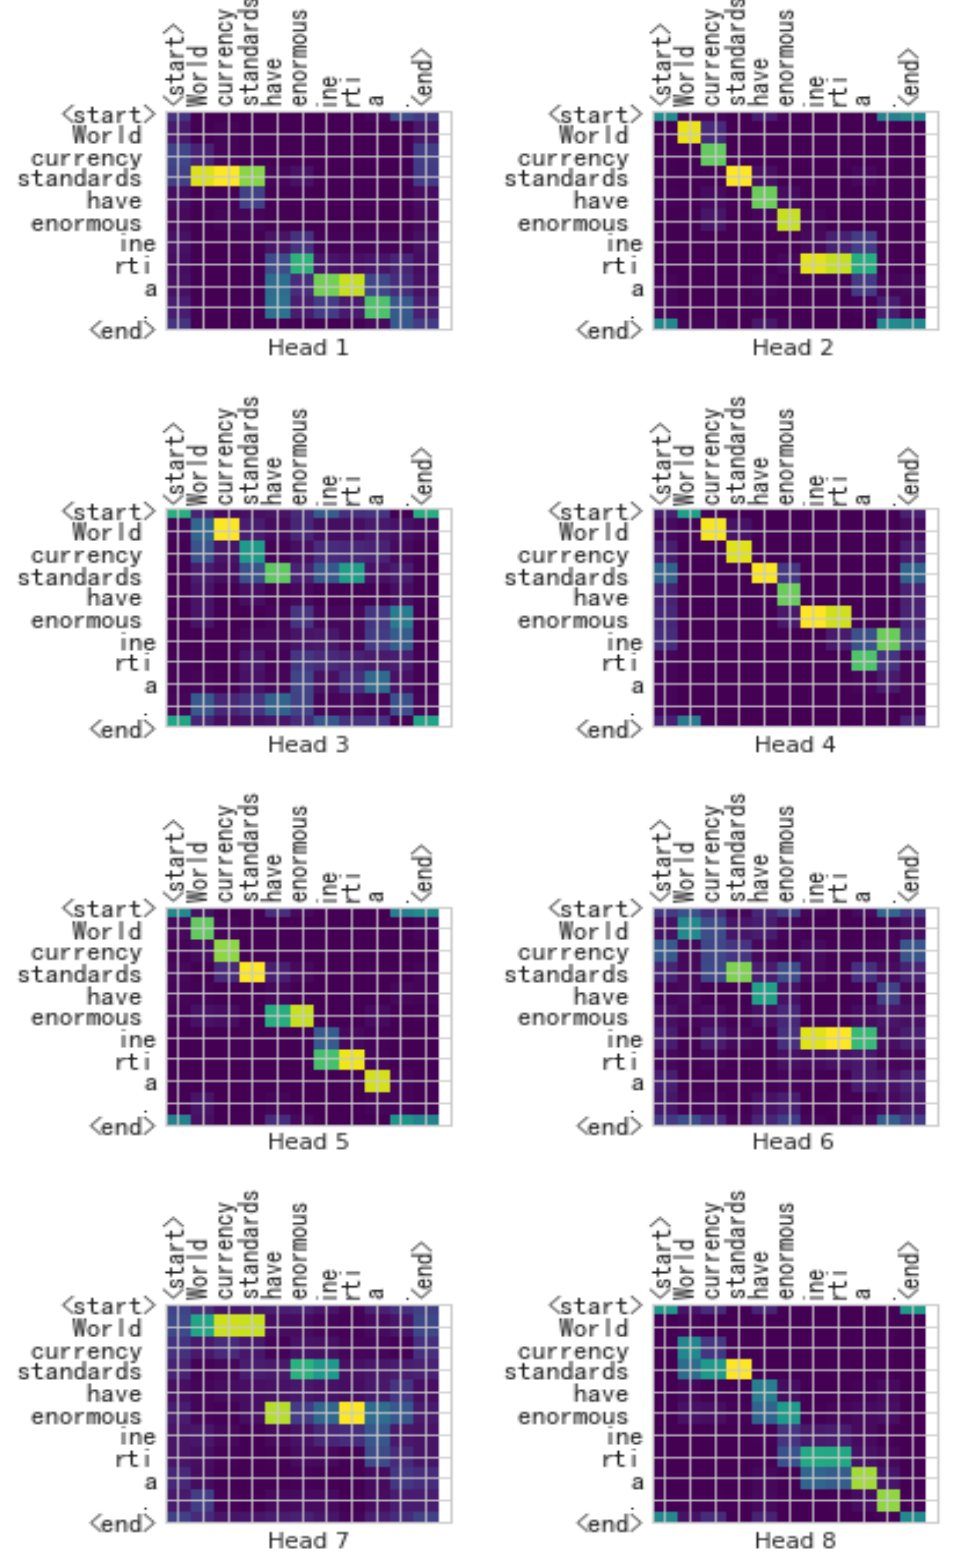
Figure 8. Heat maps of the sentence “World currency standards have enormous inertia” obtained with the X-Transformer. with the